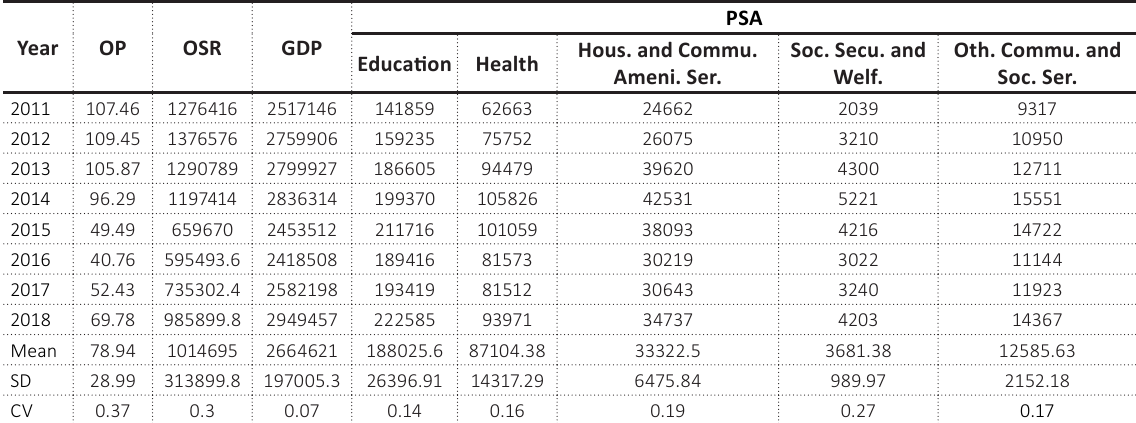
Table 1. Variability of OP, OSR, GDP, and PSA in Saudi